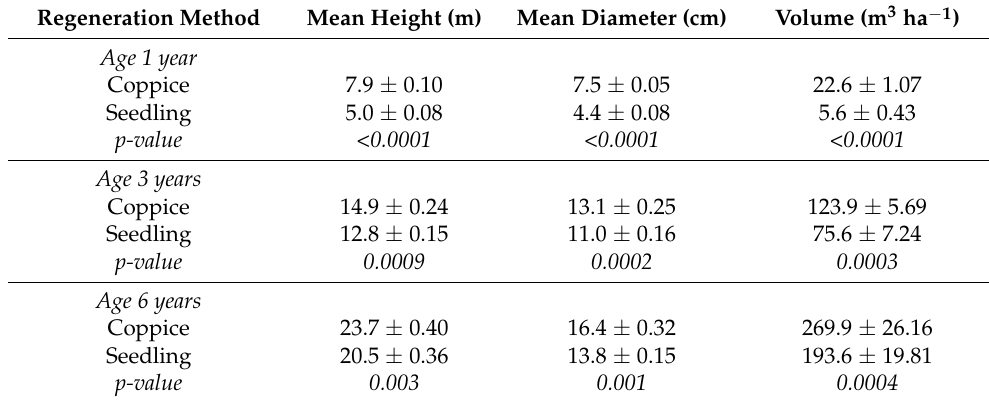
Table 2. Growth of the coppice and replanted seedling stand of Eucalyptus pellita .